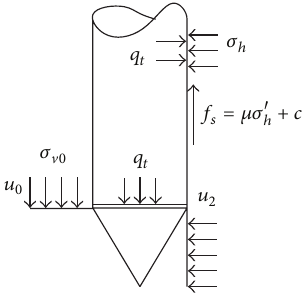
Figure 1: Tip local conditions. Cone expansion stress is 𝑞 𝑡